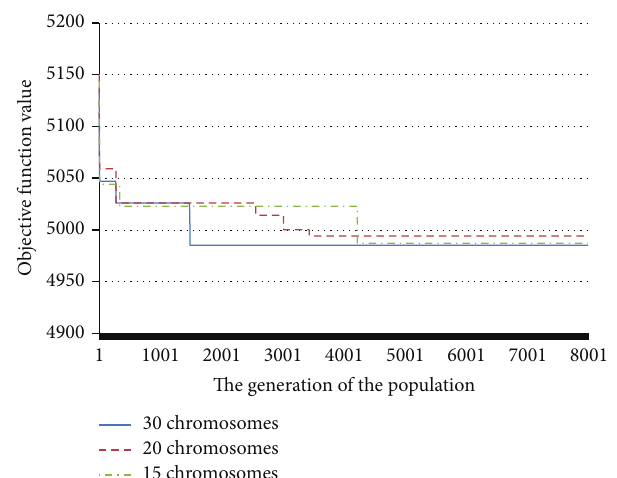
Figure 10: The comparison of the optimal objectives for different scales of